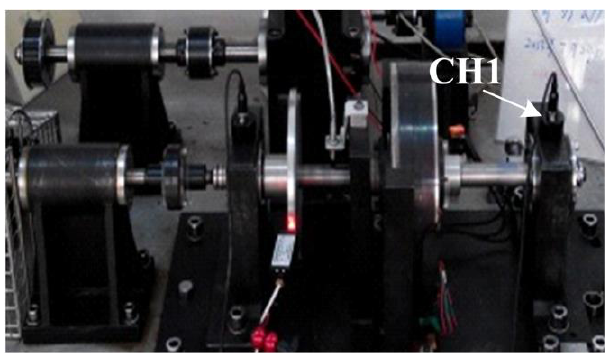
Figure 6. Experiment platform with fault rigs of a roller element bearing.